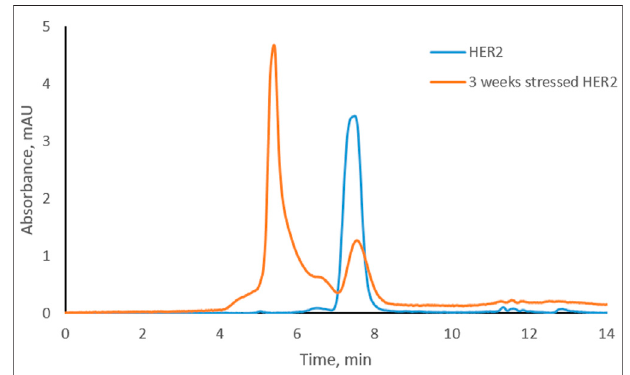
FIGURE 3 | Overlay of size-exclusion chromatograms of free HER2 at the beginning and after 3 weeks under physiological conditions.